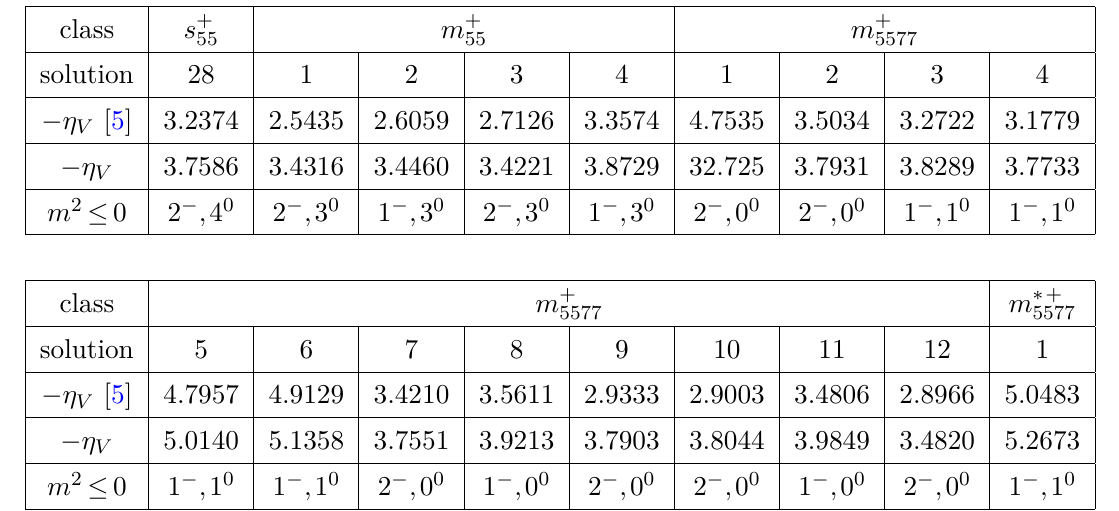
Table 7 . Spectrum information for each de Sitter solution in type IIB. We first provide the value of − η for the fields ( ρ, τ, σ ) obtained in [5], then the one obtained here with the complete set V I of scalar fields of the above dimensional reduction. By i − , j 0 , we also indicate the number j of massless modes and i of